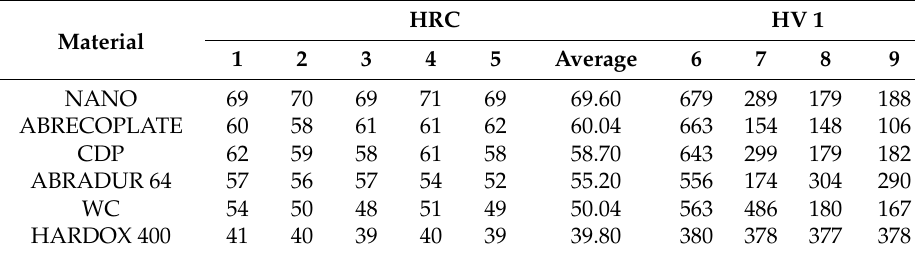
Figure 15. Average hardness of the surface of tested construction materials. Table 8. Hardness testing results on the face and cross-section of deposit welds and sheets.